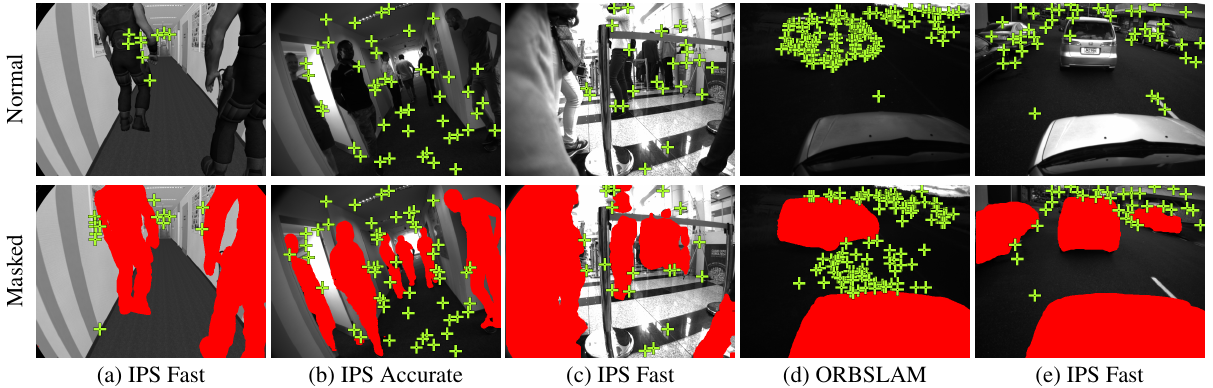
Figure 7. Illustration of selected features (green crosses) of the methods without (Normal) and with (Masked) applied segmentation aid (red area) for scenes from (a,b) the Floor- , (c) IPIN- and (d,e) NZ-Road Dataset . (a,b,c,e) show features used for pose estimation in IPS for the current frame. (d) shows the tracked keys that found ORBSLAM valid for the current